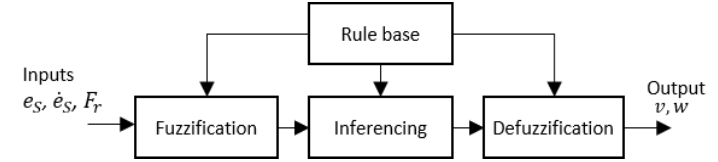
Figure 7. Architecture of Fuzzy logic system.